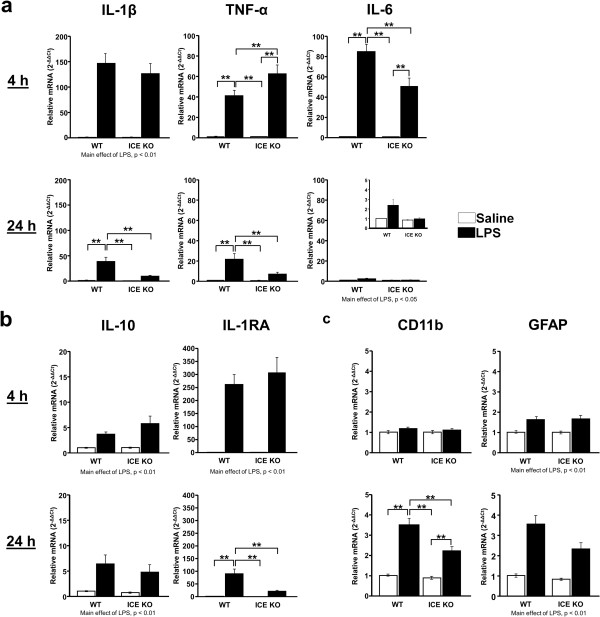
Expression of pro-inflammatory cytokines in brain was reduced in ICE KO mice at 24 h following LPS given ICV. (a) LPS increased mRNA expression of IL-1β, TNF-α, and IL-6 in WT and ICE KO at 4 h. Expression of IL-1β and TNF-α remained elevated in brains of only WT mice at 24 h. (b) IL-10 expression was increased similarly by central LPS in both strains of mice at 4 h and 24 h. In contrast, IL-1RA mRNA expression increased in both strains at 4 h but remained elevated at 24 h only in WT mice. (c) CD11b and GFAP expression were increased similarly in WT and ICE KO brains at 4 h. At 24 h, CD11b expression was reduced in ICE KO mice compared to WT mouse brains following ICV administration of LPS. Data are average mRNA expression levels relative to GAPDH ± SEM; **P <0.01, *P <0.05 comparing bracketed groups; main effects of LPS where indicated; n = 6 mice per group. Insets: Data presented with zoomed in scale to ease interpretation. Mean Ct values for saline treated WT groups were: IL-1β, 31.7 ± 0.4; TNF-α, 32.0 ± 0.3; IL-6, 31.6 ± 0.4; IL-10, 34.6 ± 0.2; IL-1RA, 33.2 ± 0.3; CD11b, 20.7 ± 0.03; GFAP, 17.4 ± 0.1.